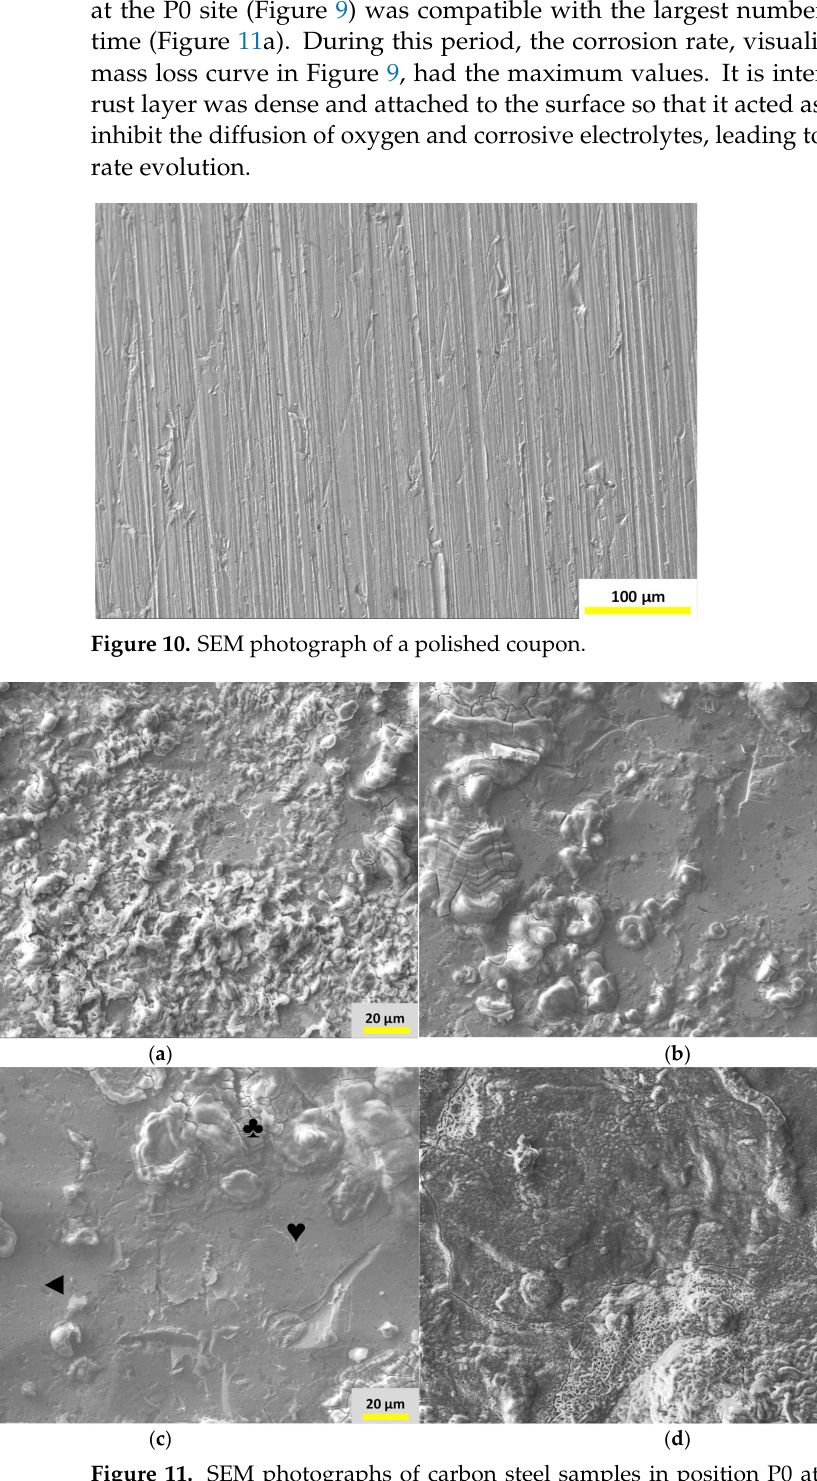
Figure 11. SEM photographs of carbon steel samples in position P0 at 32 days ( a ), 74 days ( b ), 120 days ( c ), and 241 days ( d ) of exposure.